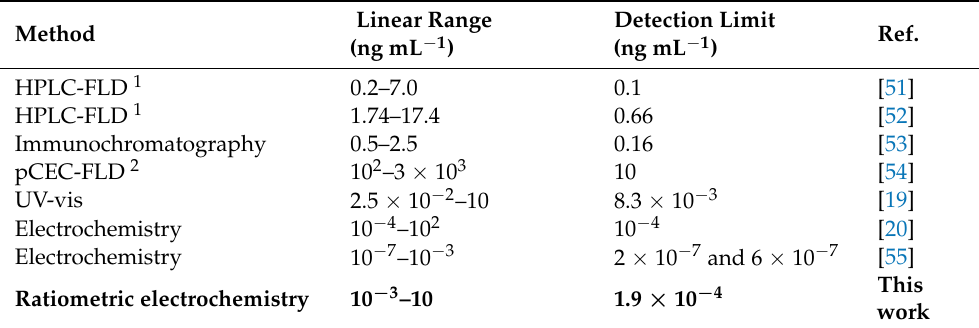
Table 1. Comparisons of the developed aptasensor with several previously reported methods for AFB2